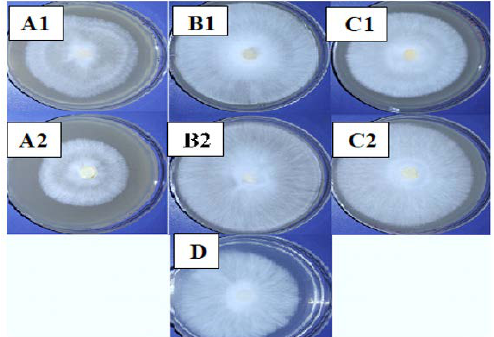
Fig. 6. Colony growth of M. palmivorus on culture media from powdered leaves of the following plants with dextrose (1) and without dextrose (2): A (wheat), B (reed), C (I. cylindrica ), and D (PDA) after 4 days of incubation at 30 o C